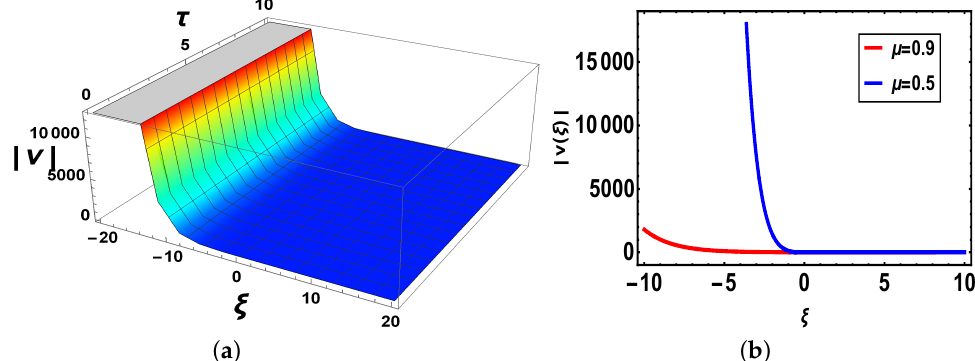
Figure 1. ( a ) 3D-plot with parameter values B = e , a = 2.5, µ = 0.9, ω = 1, b = 1, κ = 2.3, α = 1.2, β = 6, γ = 2.9, θ 3 = 2.7, ν = 4, m = 1, n = 1 ( b ) 2D-plot for different values of µ of v 3 ( ξ , τ ) with beta-derivative.